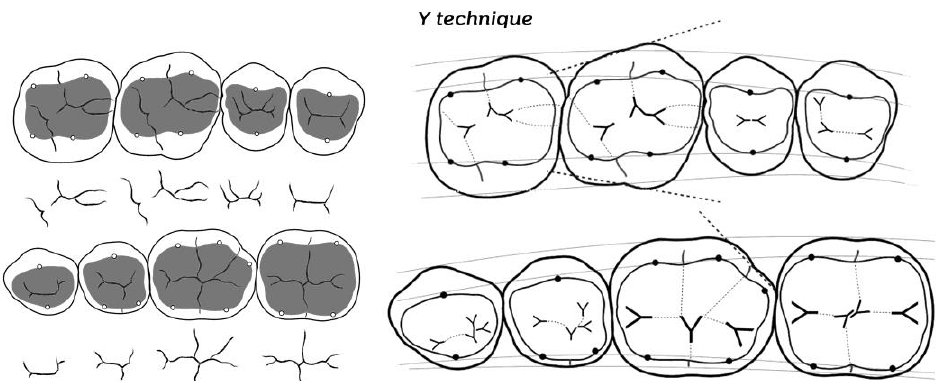
Figure 1. Stylization of the occlusion maps using the Y technique for posterior teeth. Left: The three key elements used to construct the posterior teeth. The occlusion maps are inserted into the occlusal tables (gray areas), which in turn have their boundaries established by the cusp tips (white spheres) surrounded more externally by the external tooth silhouette or contour. Right: A stylized drawing of the occlusion maps of the posterior teeth using the Y technique.